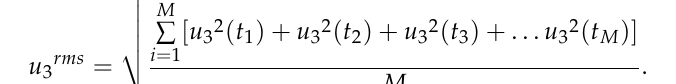
the coordinate (200 mm, 150 mm, 2 mm), with a 1 ms duration and a 1 MHz sampling rate, where